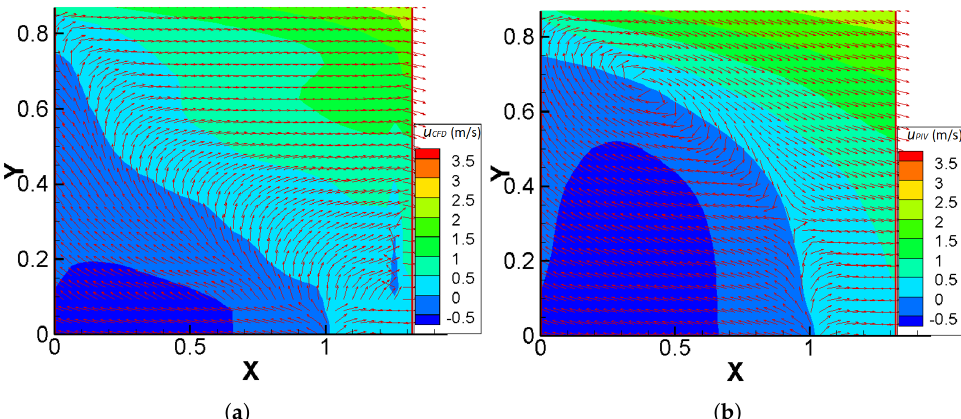
Figure 14. Contours of u (m/s) and vectorial fields of u t (in the same figure) on a region near the south boundary of plane C, extracted by: ( a ) CFD methodology ( u CFD ), ( b ) PIV experimental technique ( u PIV ) with X and Y being non-dimensional coordinates. Flow is from left to right.